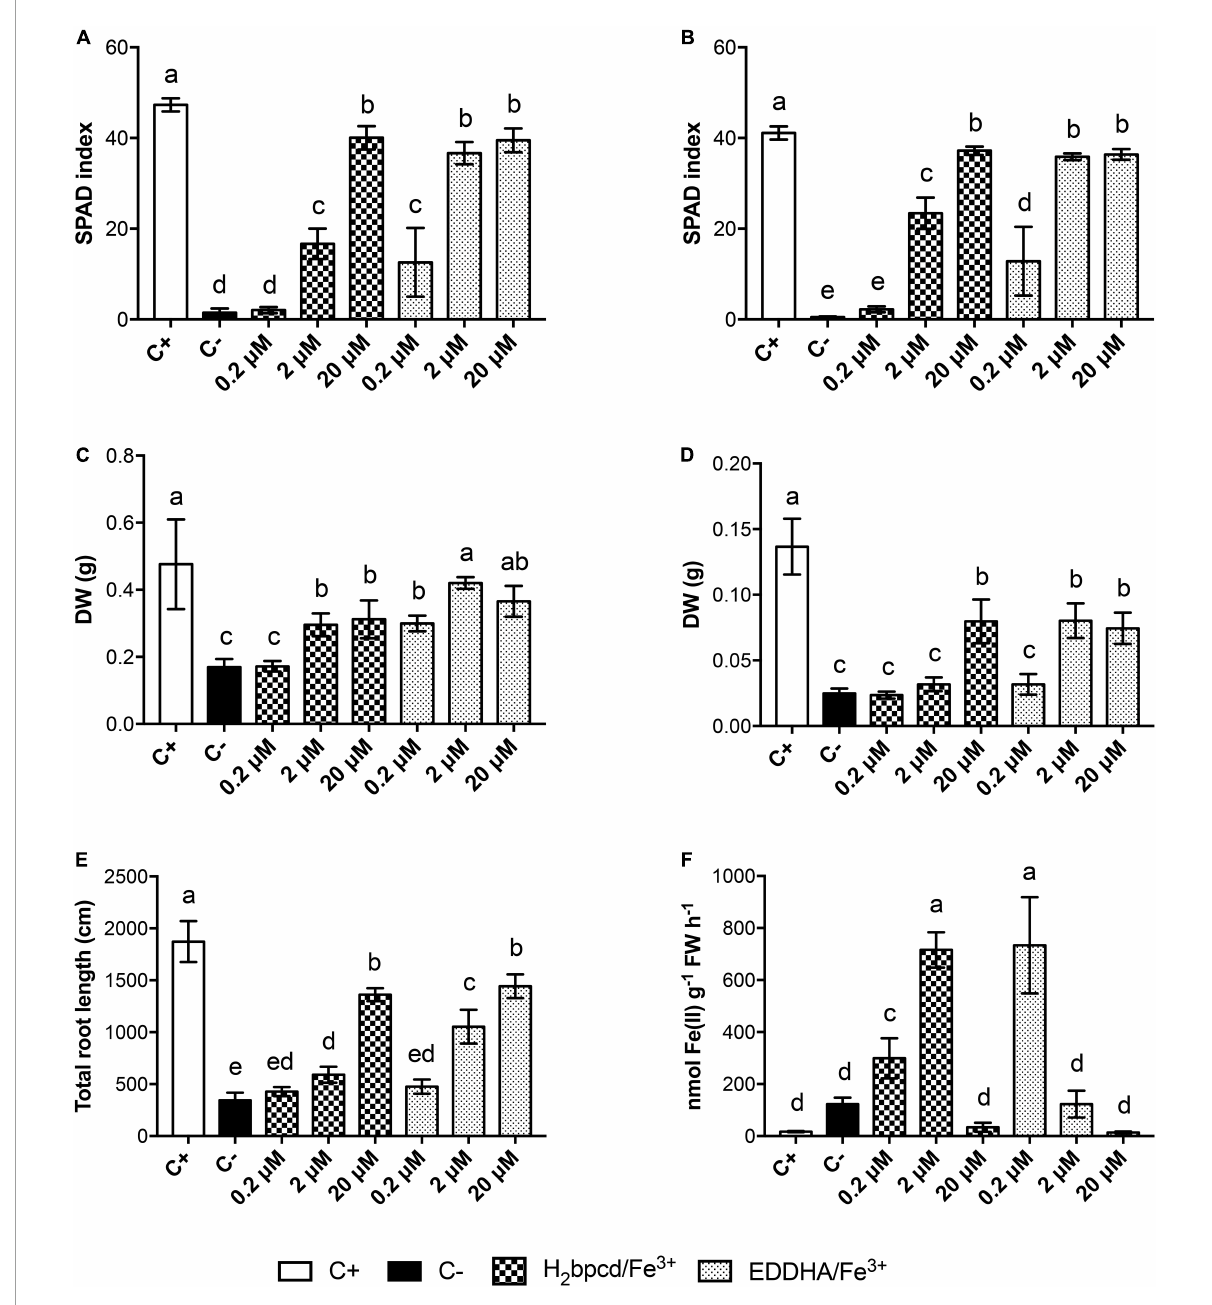
FIGURE6 Morpho-physiological parameters of Fe-deficient cucumber plants supplied with H 2 bpcd/Fe 3 + and EDDHA/Fe 3 + for 7 days. (A) SPAD index of the first leaf, (B) SPAD index of the second leaf, (C) shoot DW, (D) root DW, (E) total root length (F) , and FCR activity. Data represent mean ± S.D. of three independent replicates with four plants each ( n = 12) for panels (A,B) and two plants each ( n = 6) for panels (C–F) (one-way ANOVA with Turkey’s post hoc test, p < 0.05, significant differences are indicated by different letters).